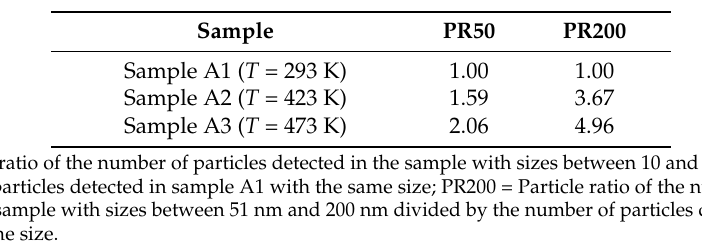
Table 4. SEM-FEG metallographic results (based on nine measurements).